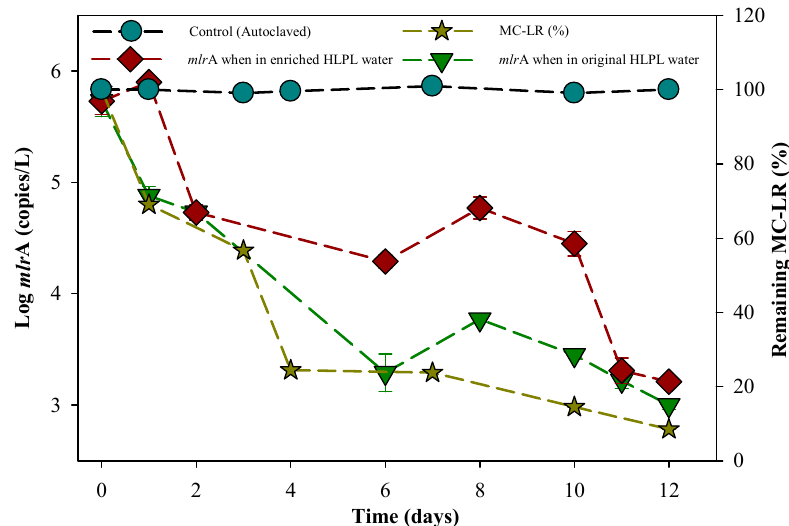
Figure 7. Evolution in mlr A gene abundance and MC ‐ LR degradation in enriched water within the batch culture. The enriched water had an initial MC ‐ LR concentration of 0.014 mg ∙ L − 1 (The error bars represent one standard deviation for three measurements).